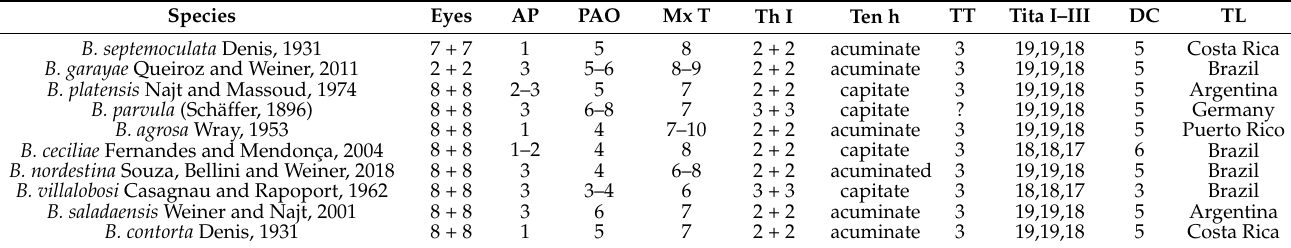
Table 5. Morphological characters of Brachystomella Agren, 1903 species recorded from Brazil.; AP—apical bulb vesicles; PAO— PAO vesicle number; Mx T—maxilla teeth; Ten h—tenent hair; TT— tenaculum teeth; DC—dental chaetae number; TL—type locality; “?” —missing